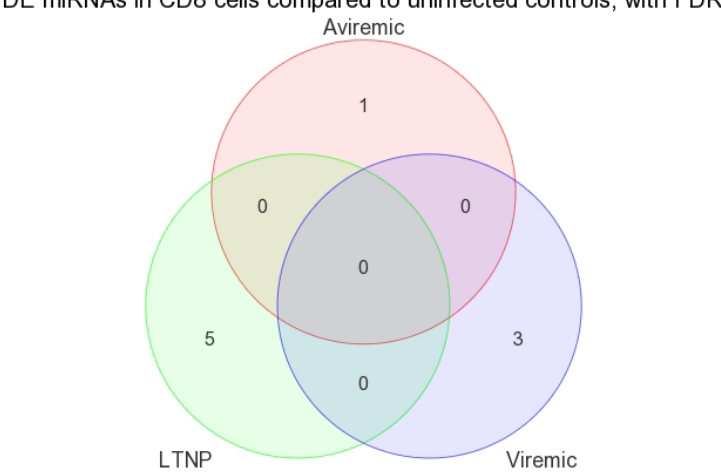
Figure 10. Venn diagram of DE miRNA in CD8+ T-cells when disease groups were compared to HIV– controls. FDR method with p < 0.05 was used. Viremic n = 6, aviremic n = 5, LTNP n = 4, negative n = 3.